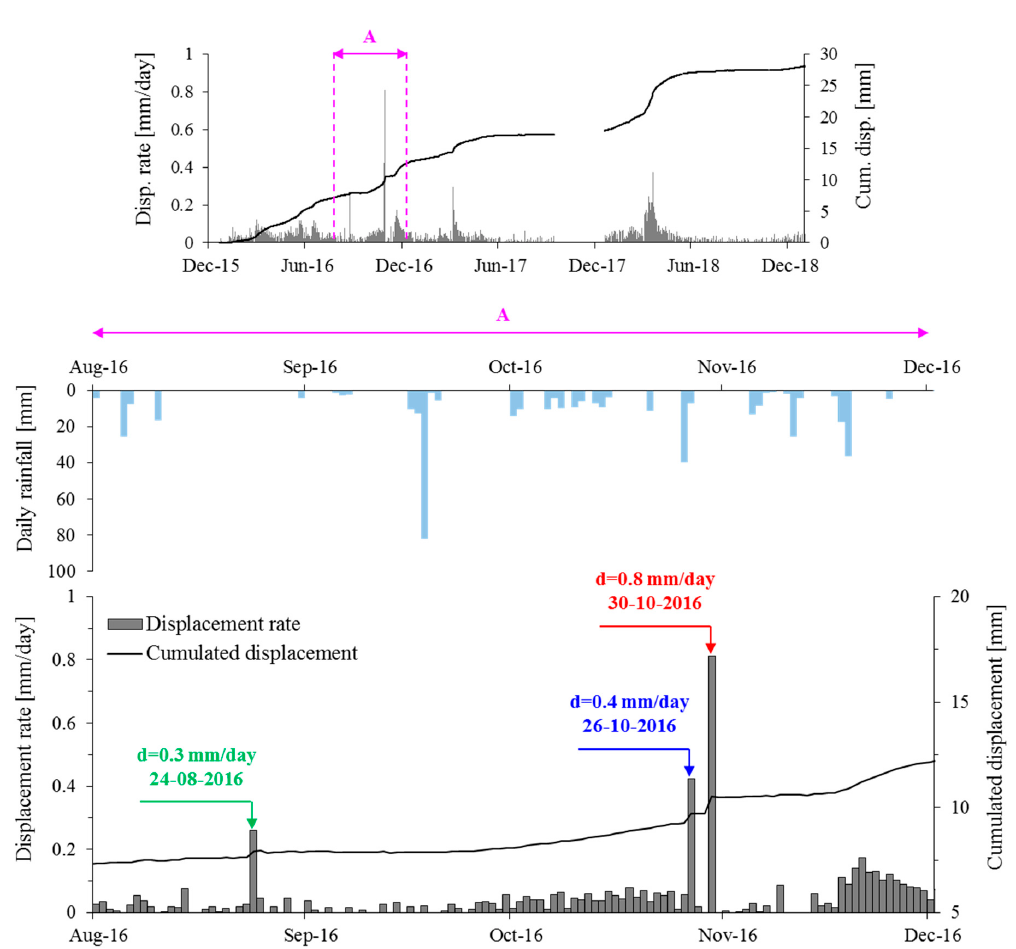
Figure 10. Daily and cumulated displacement from AI11 in-place inclinometer probes with a focus on the period of the three strong earthquake events of the seismic sequence; daily rainfalls are reported for the same period.